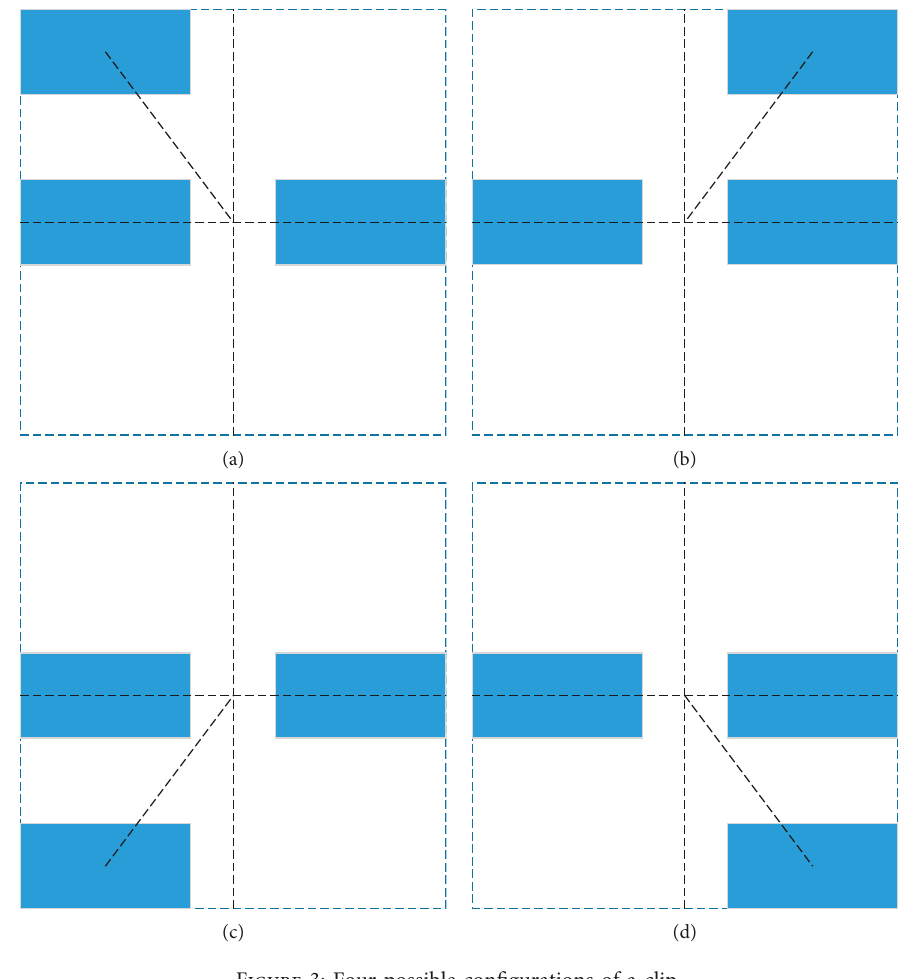
Figure 3: Four possible configurations of a clip.